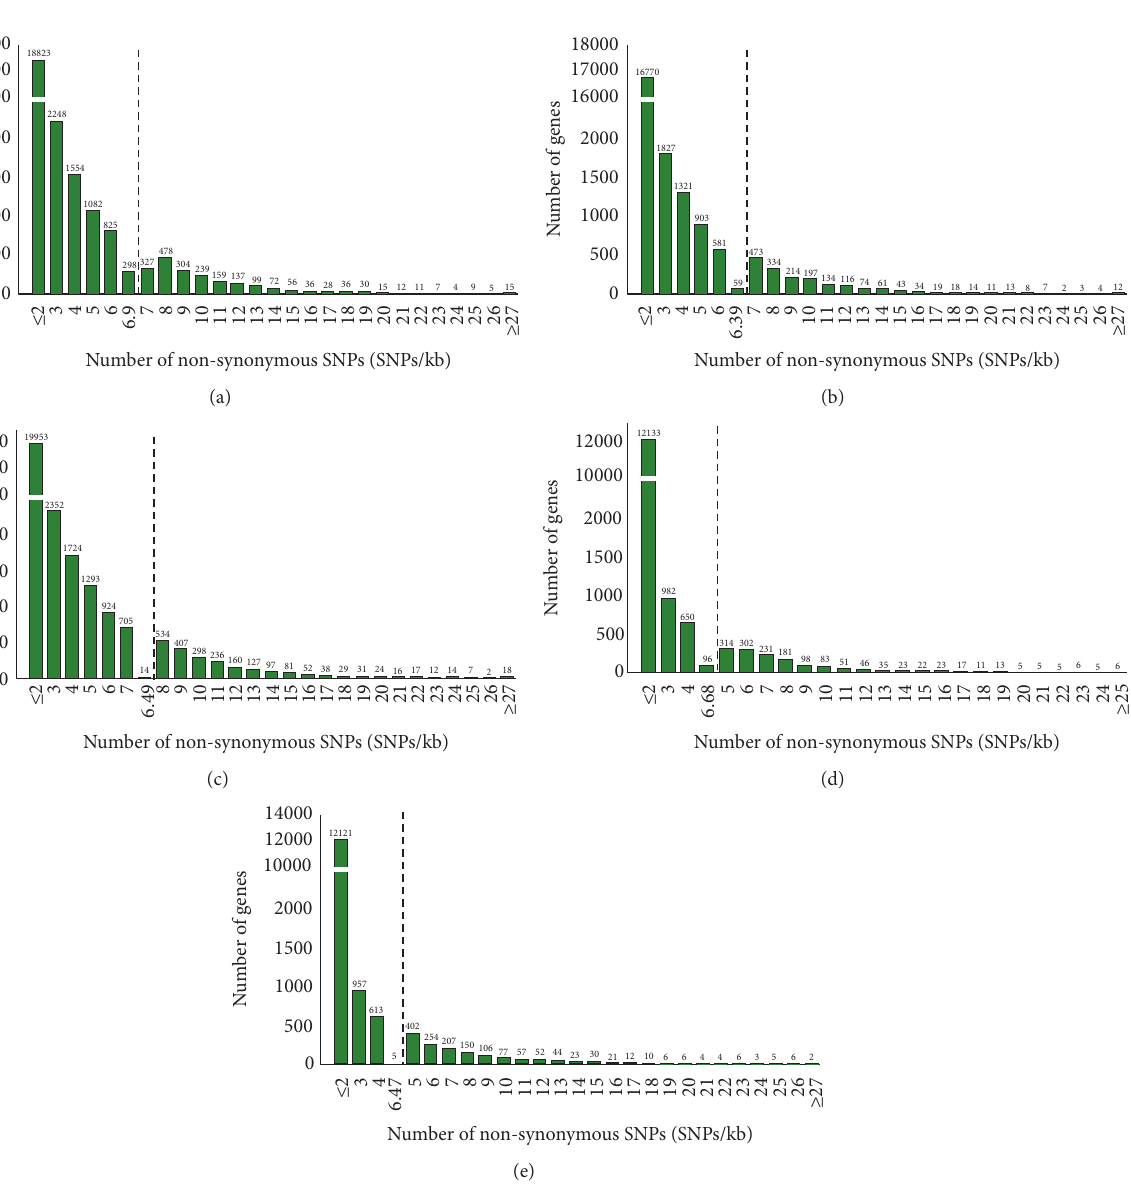
Figure 6: The distribution and skewness of the nonsynonymous SNPs. SNPs per 1 kb in (a) indica 12, (b) indica 13, (c) indica 15, (d) japonica 11, and (e) japonica 14. The black dash indicates the outlier value cutoff.